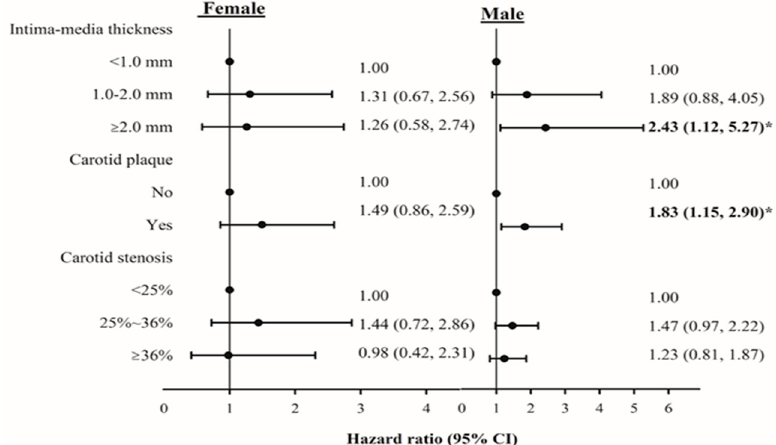
Figure 3. Adjusted hazard ratios (HRs) of mortality stratified by gender. * p < 0.05.